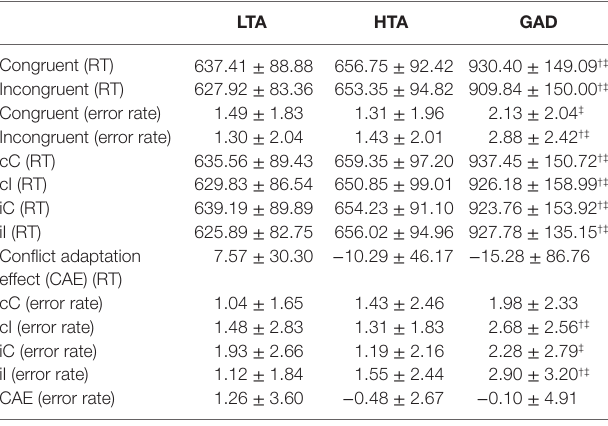
TaBle 2 | Mean RTs and error rates in emotional Flanker task (mean ± SD).